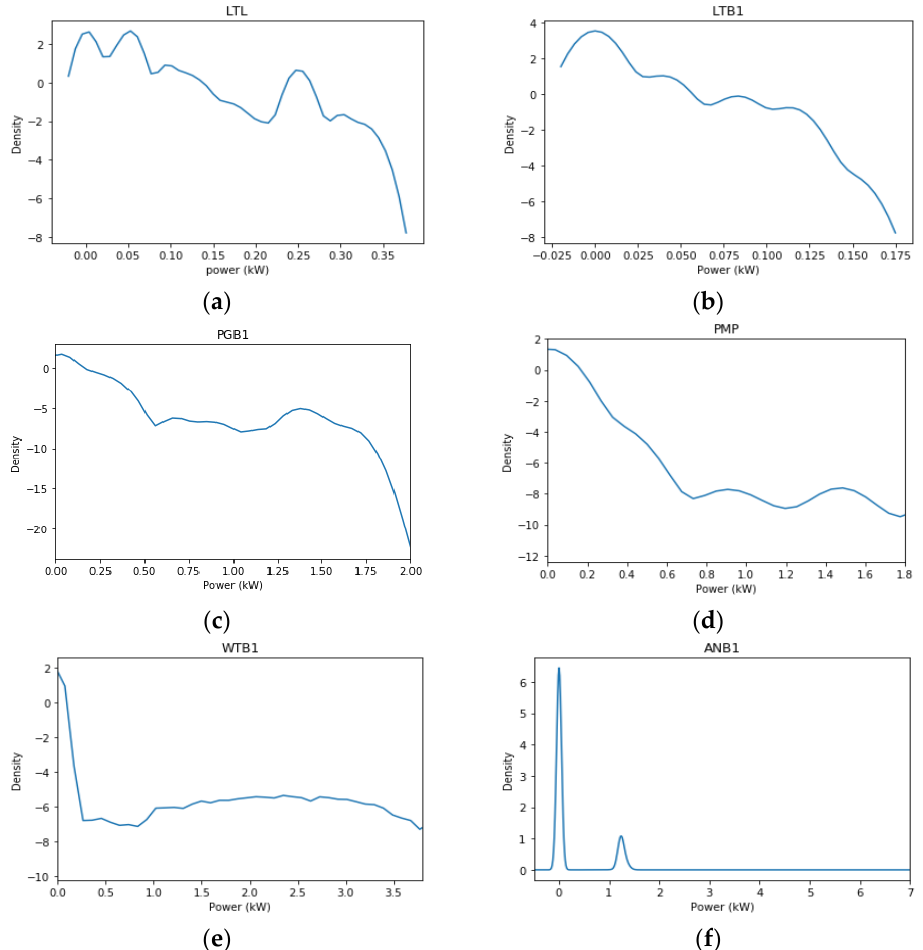
Figure 2. Power distribution through KDE plots for appliance label ( a ) LTL; ( b ) LTB1; ( c ) PGB1; ( d ) PMP; ( e ) WTB1; and ( f ) ANB1. Table 2. Power state representation of appliance label using KDE